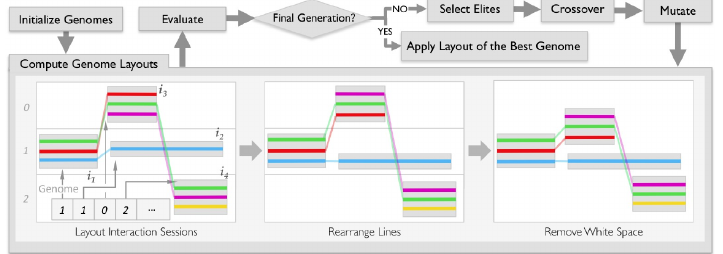
Figure 25. Tanahashi and Ma present the overview algorithm of generating storyline visualizations [48]. Image courtesy of Tanahashi et al. [48].